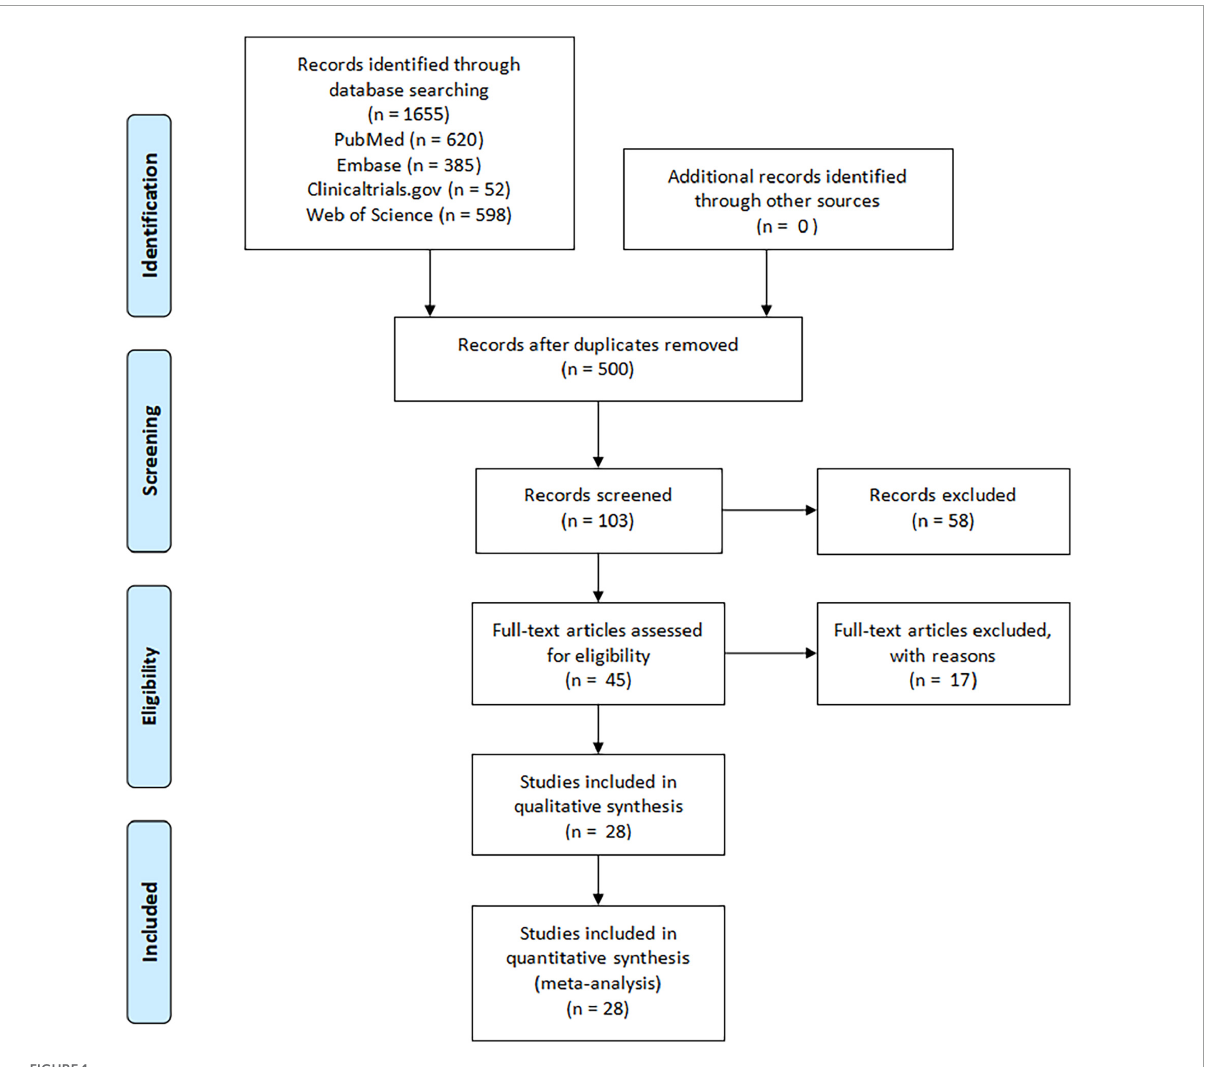
FIGURE1 The PRISMA flow